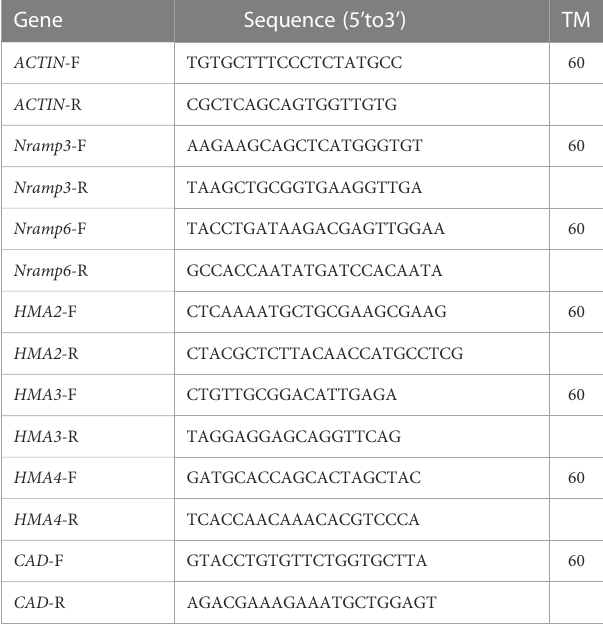
TABLE 1 Sequences of speci fi c-primers used for